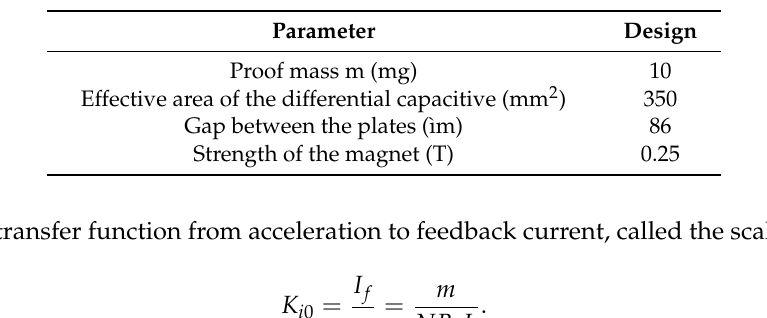
Table 1. Physical parameters of the